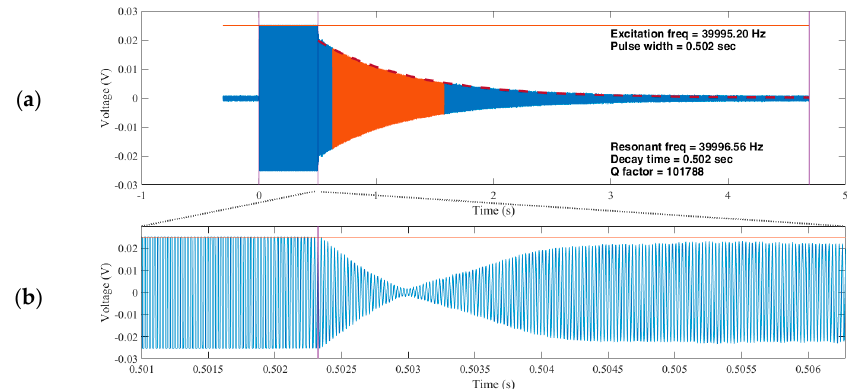
Figure 3. Backscattered signal: ( a ) Excitation pulse width of 0.502 s and ringing of the high-Q factor resonator at resonance frequency with an envelope fit (red dashed) to the decay for Q factor calculation; ( b ) Shift from excitation frequency to resonance frequency.